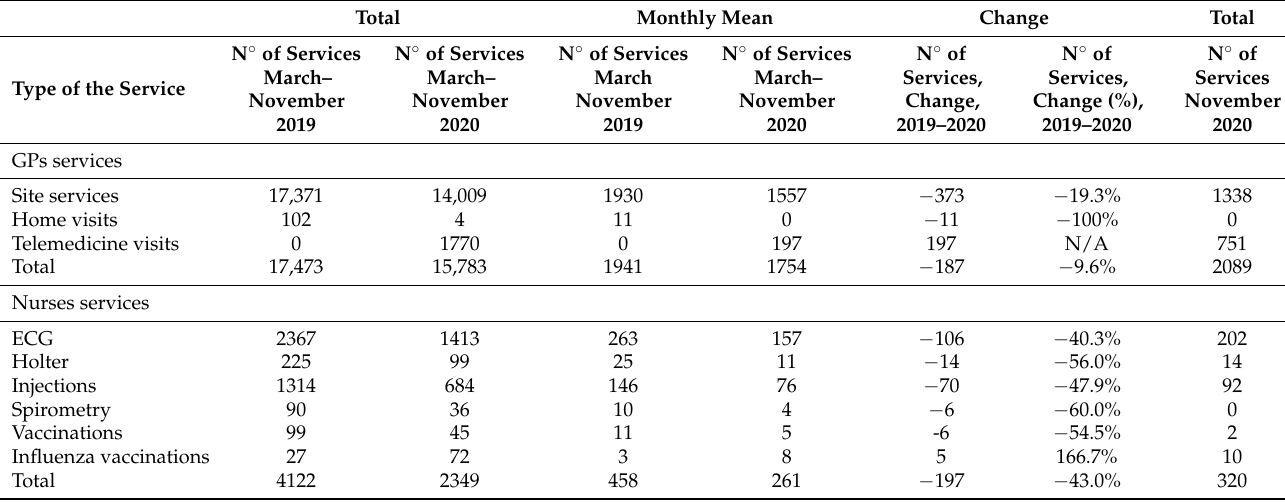
Table 4. Number of services provided by GPs and nurses from Clinic 1 in the periods March–November 2019